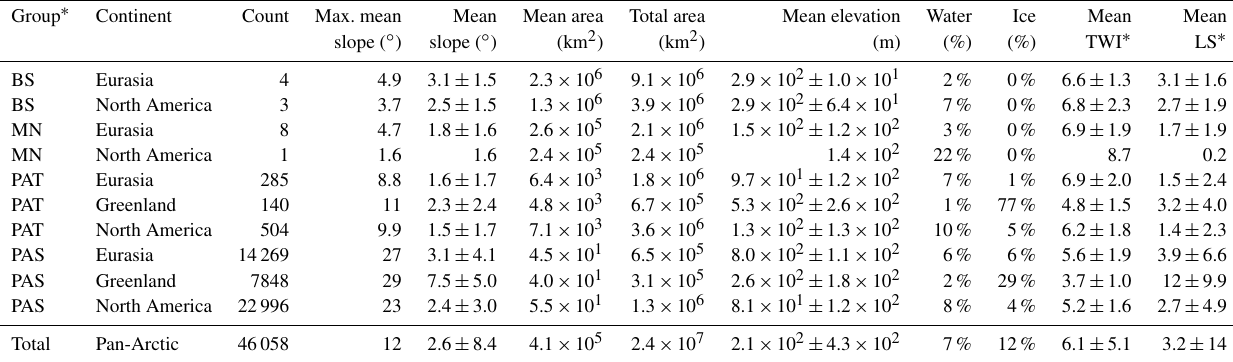
Table 2. Watershed topographic properties summarized by group (classification based on area) and relevant (sub)continent. Group ∗ Continent